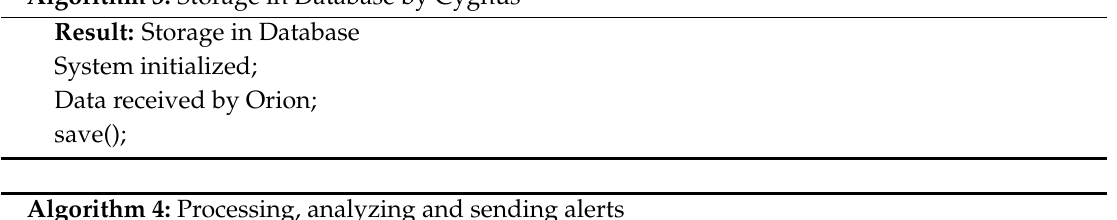
Algorithm 3: Storage in Database by Cygnus